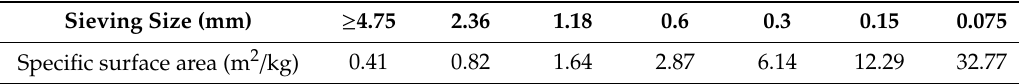
Table 1. Specific surface area of aggregates.